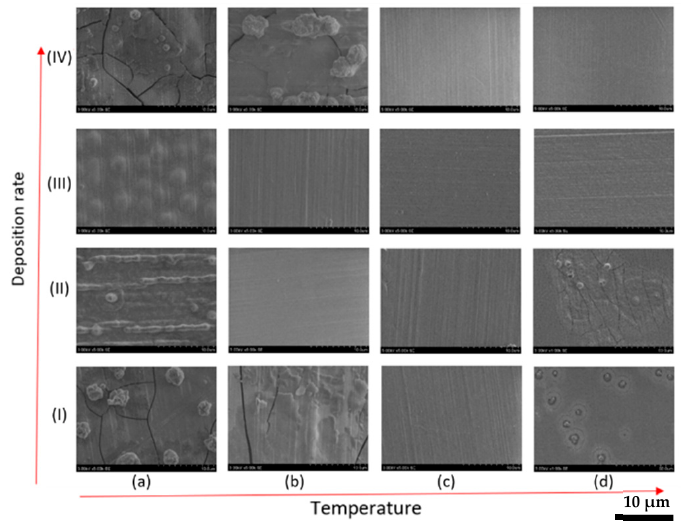
Figure 3. SEM of BCO thin films (×5 k magnification) on Inconel alloy substrate at different temperatures (20 °C ( a ), 150 °C ( b ), 450 °C ( c ), 600 °C ( d )) and deposition rates (2 Å/s (I), 4 Å/s (II), 8 Å/s (III), 12 Å/s (IV)).